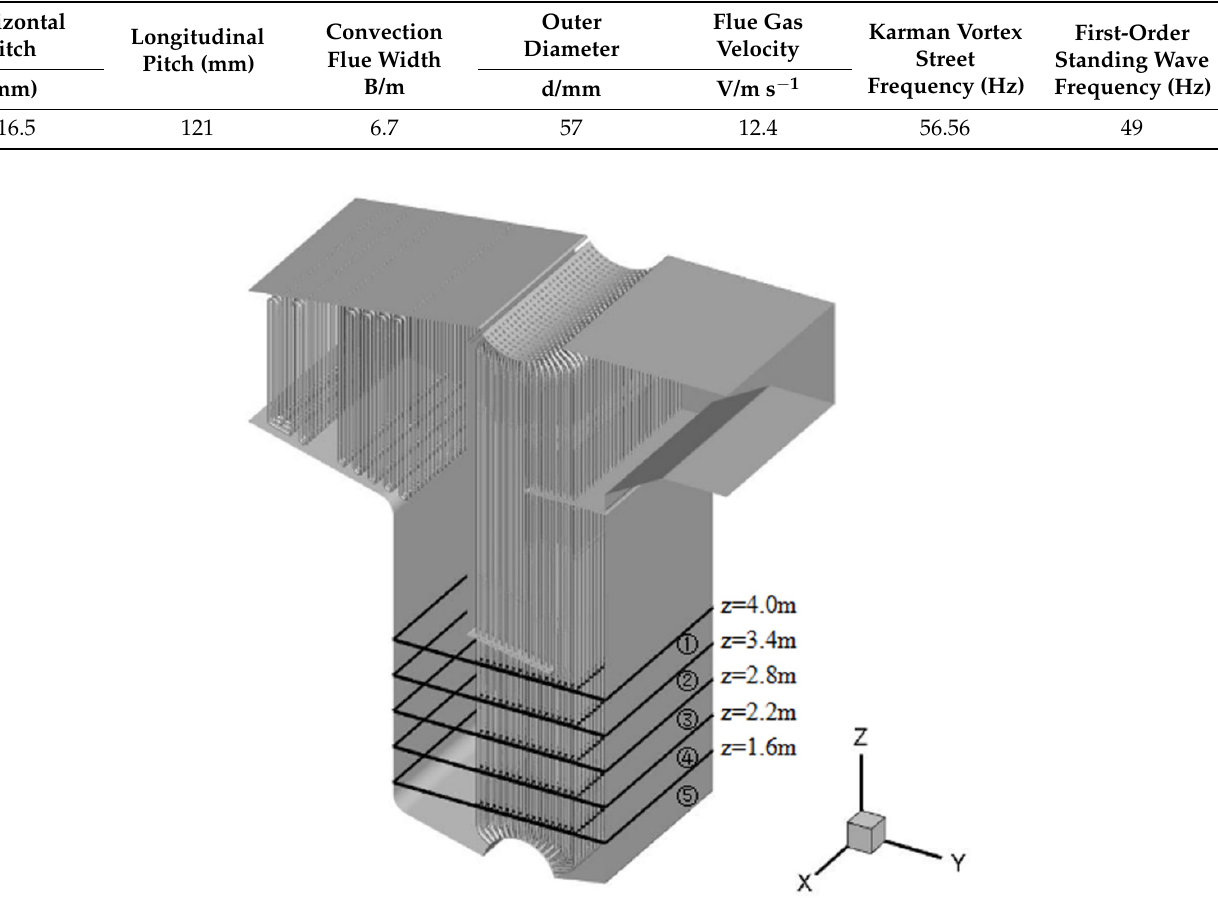
Figure 1. Schematic diagram of the lower end of the convection zone.